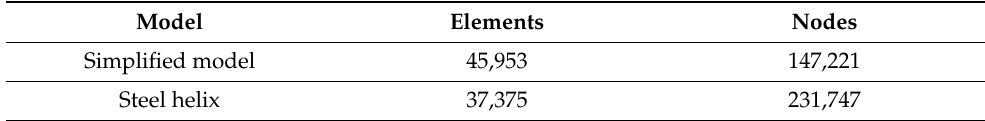
Table 4. Mesh statistics on the element/node count for the simplified